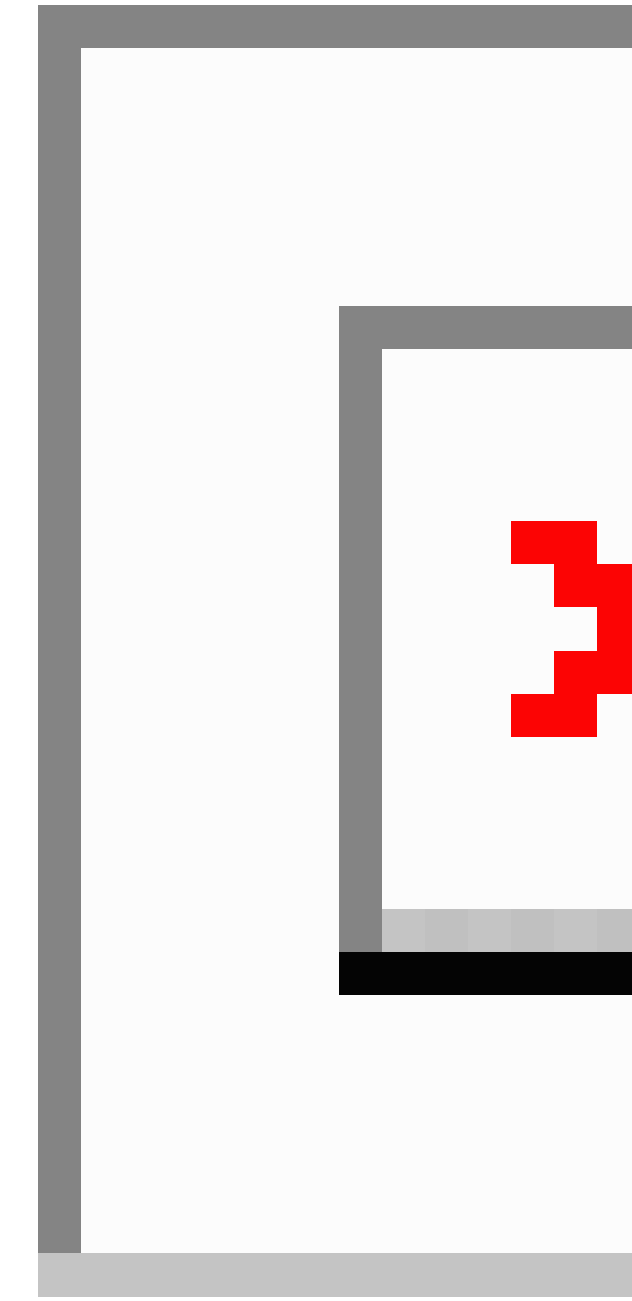
Figure 2. Distribution of depression apps by